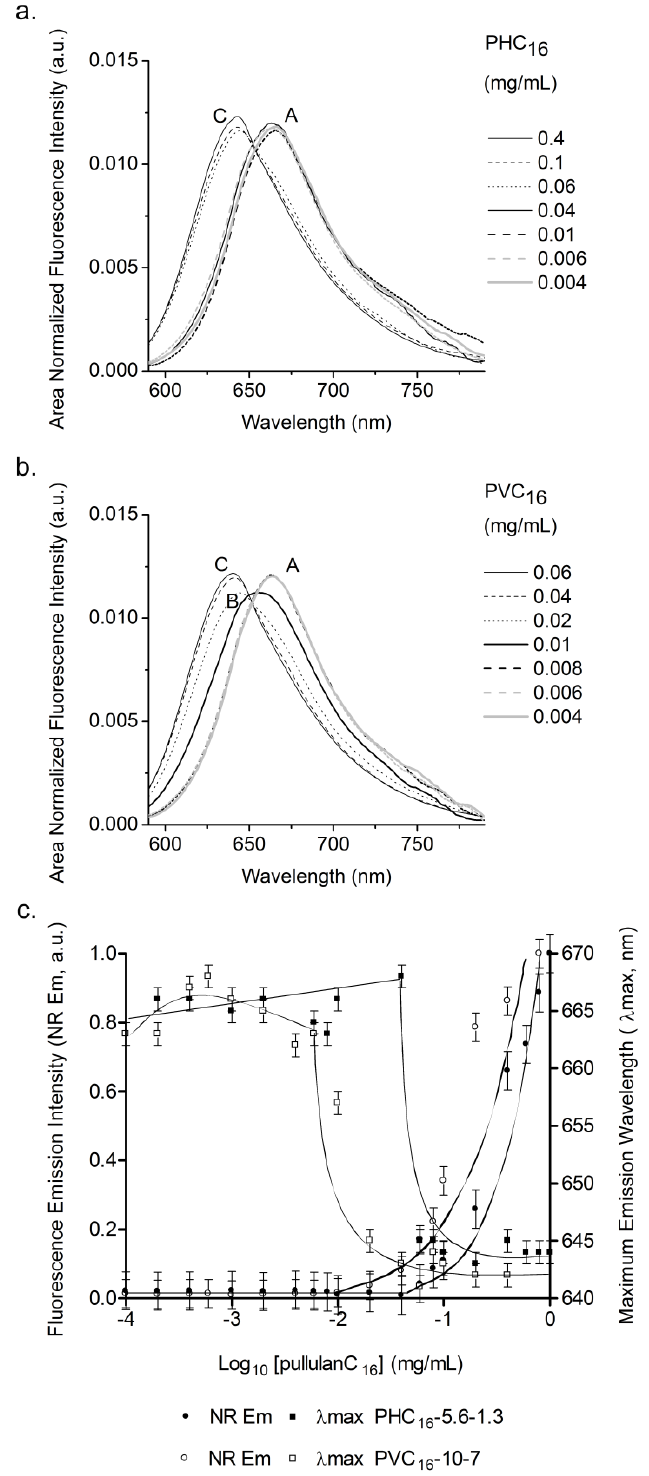
Figure 3. Determination of the cac of pullulan-C using area normalized fluorescence 16 emission (λ = 570 nm) spectra of NR (2 × 10 −7 M) in the pullulan-C /water system as a ex 16 function of ( a ) PHC -5.6-1.3 and ( b ) PVC -10-7 concentration; ( c ) area normalized 16 16 fluorescence emission intensity and position of maximum emission wavelength of Nile red (NR) in the pullulan-C /water system as a function of pullulan-C concentration. The cac 16 16 obtained for PHC -5.6-1.3 was 0.04 mg/mL and for PVC -10-7 was 0.01 16 16